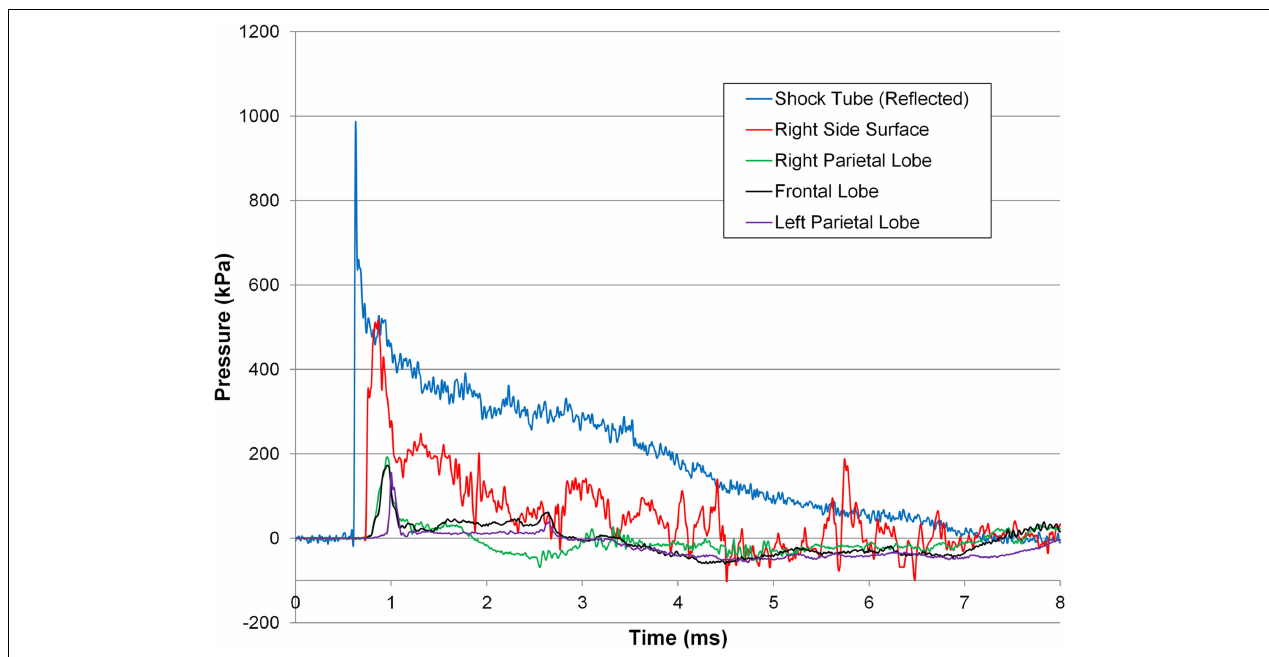
FIGURE 5 | Pressure response for a 274 ± 6.9-kPa peak incident overpressure 6.72 ± 0.55-ms positive phase duration shock wave.